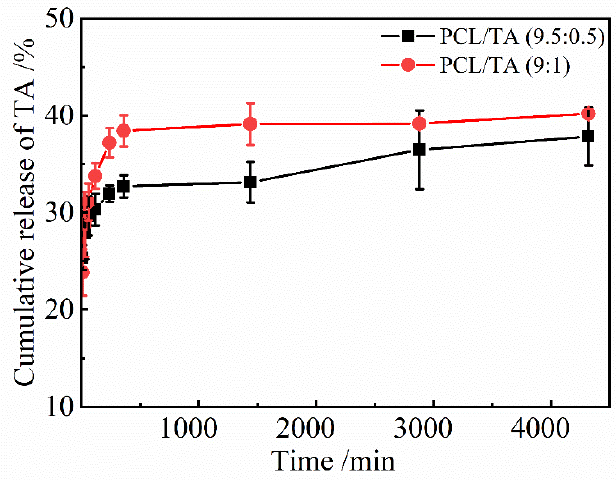
Figure 6. TA release from PCL/TA nanofiber scaffolds spun from solutions with different PCL/TA weight ratios (9.5:0.5 and 9:1) in deionized water.